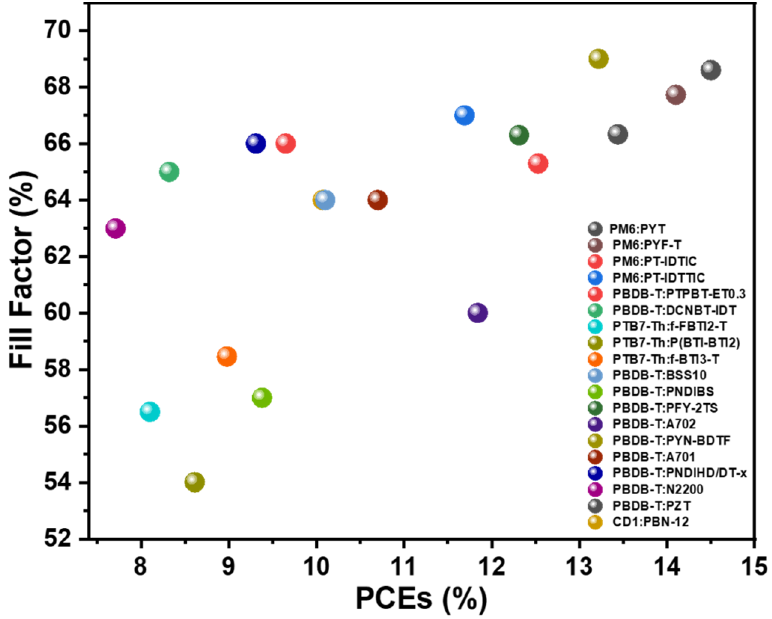
Figure 1. Fill Factors and PCEs for several high-performance all-polymer solar cells in recent